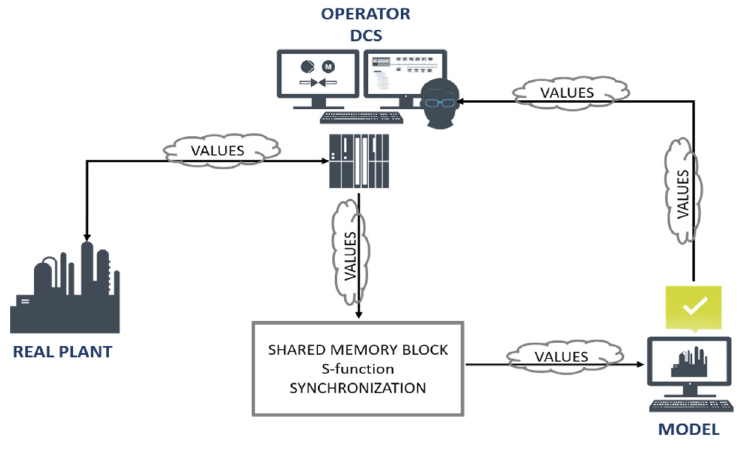
Figure 1. Integrated model for continuous monitoring and optimization of the steam methane reformer (SMR) catalyst.